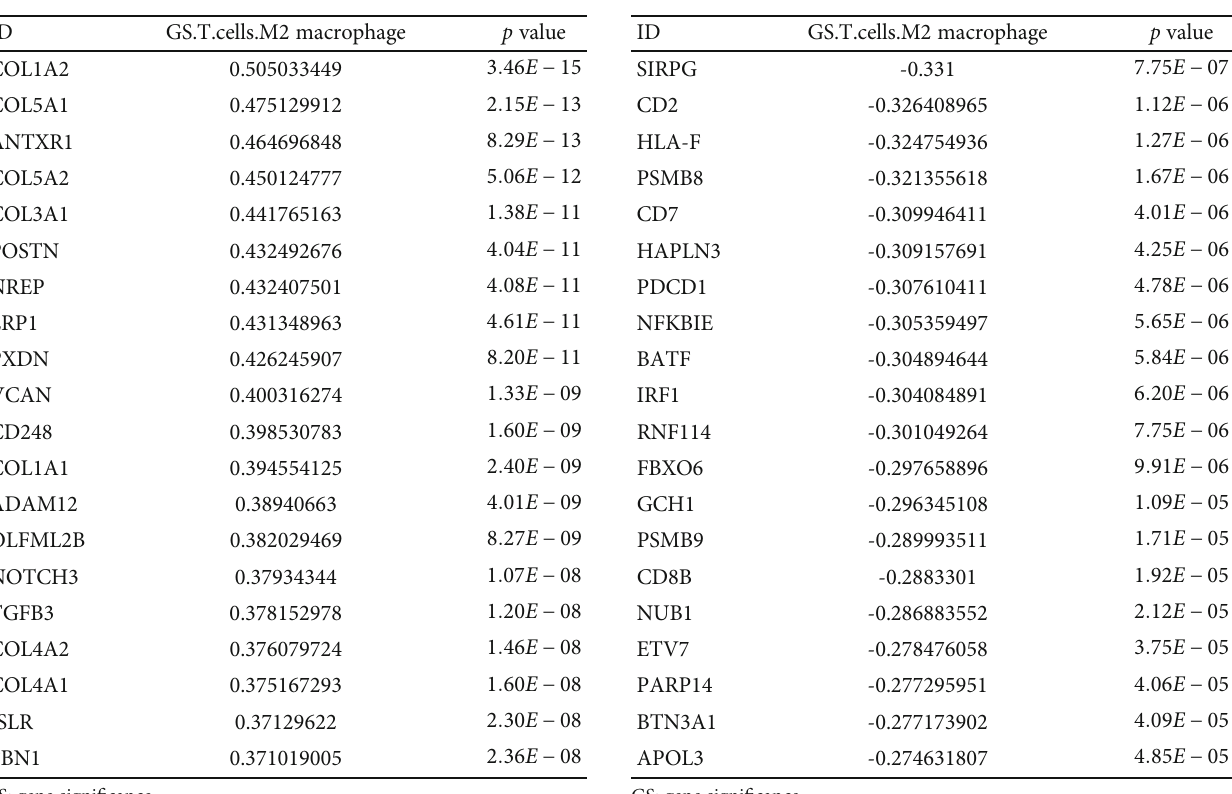
Table 1: The top 20 gene signi fi cance for M2 macrophage cell- related genes in the green-yellow module.